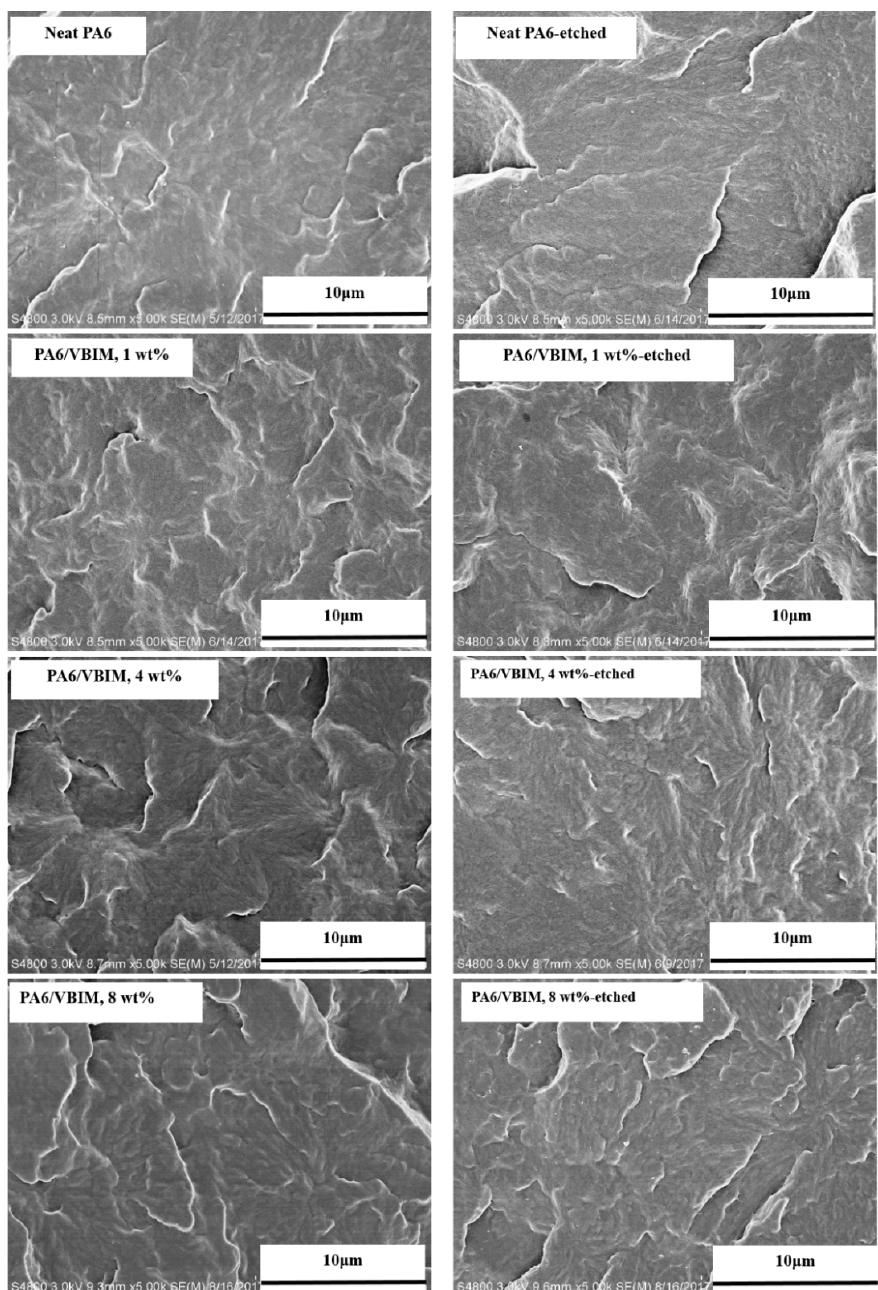
Figure 1. SEM images of the cross-fracture surface of PA6 and PA6/VBIM blends with different VBIM loadings before and after etching.